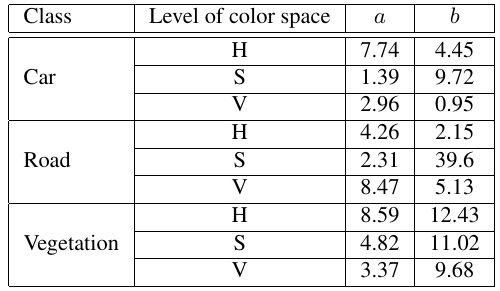
Table 2: a and b of beta distribution for histograms of car, road and